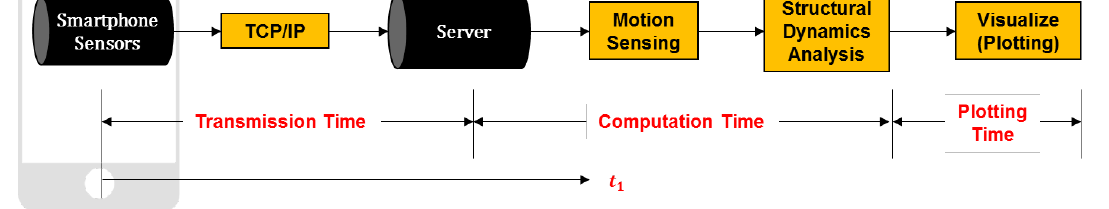
Figure 14. Overview of time and data synchronization.